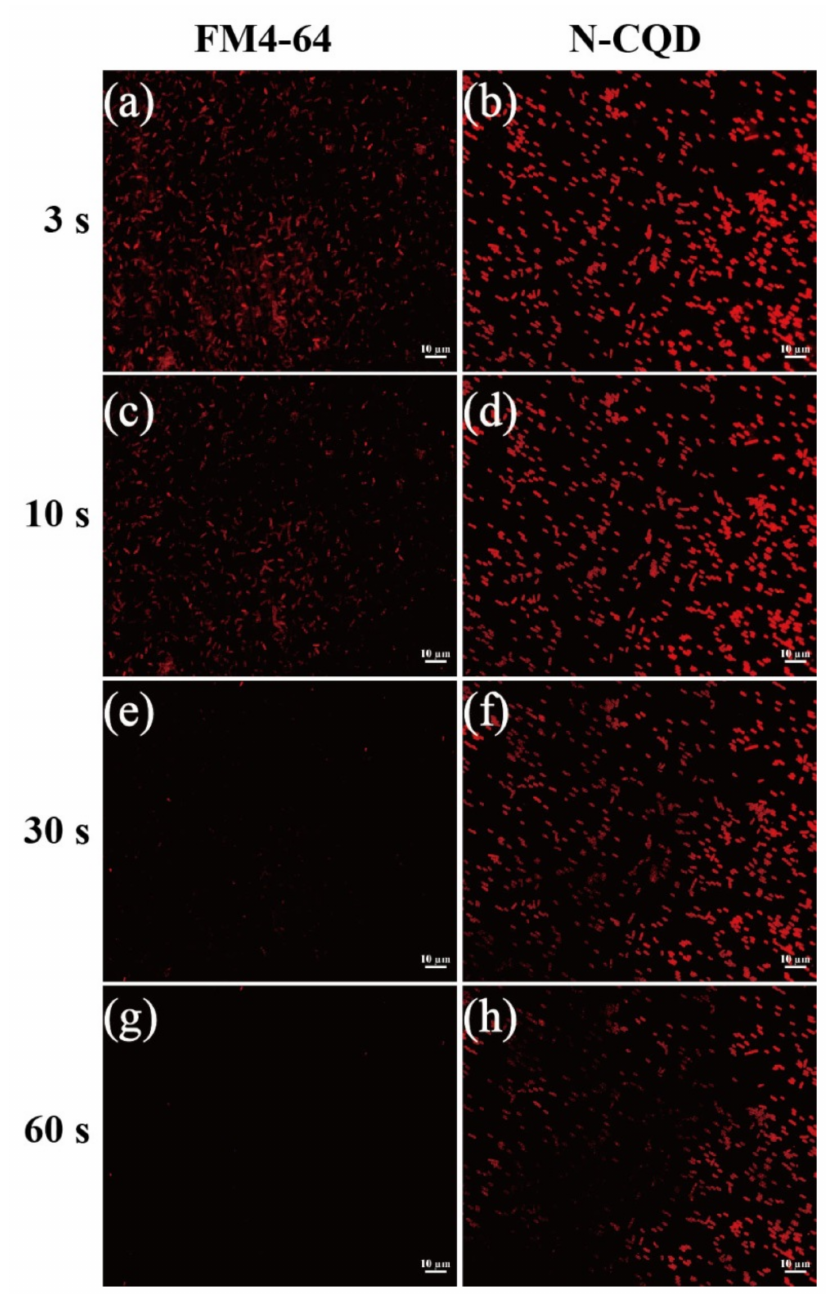
Figure 9. Fluorescence microscopy images of B. subtilis stained with N-CQDs ( b , d , f , h ) and FM4-64 ( a , c , e , g ) membrane dye after 3 and 30 s of excitation at 490 nm. Bacillus cells were stained with 1000 ppm N-CQDs. Red fluorescence was detected under TRITC filter set. Scale bar represents 10 µ